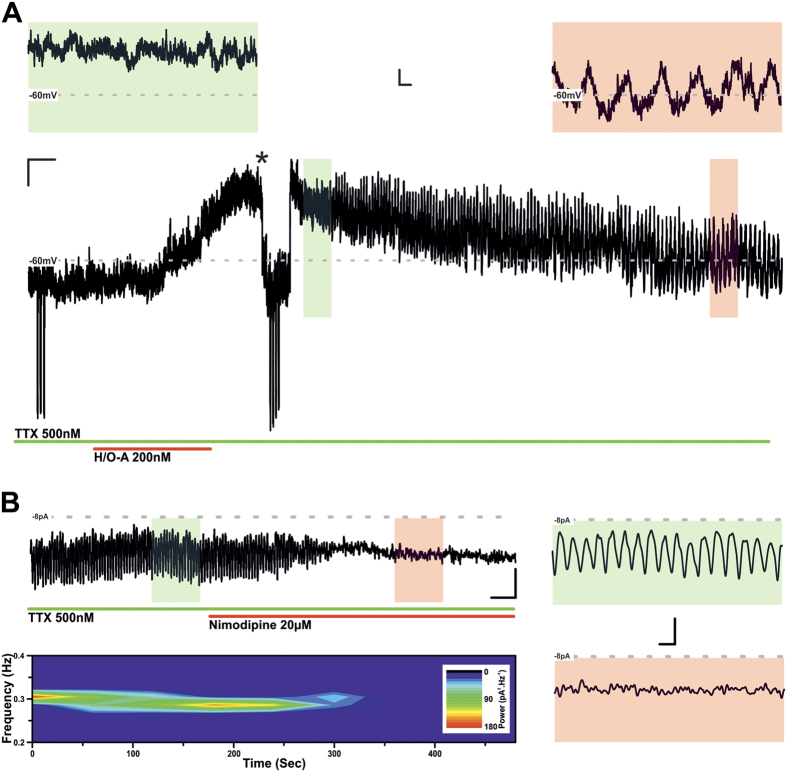
Hypocretin/Orexin-A activates a TTX-insensitive L-type dependent membrane potential oscillation.(A) Current clamp recording of an oscillating TIDA neuron in the continuous presence of TTX. Prior to application of H/O-A, neuron was held at −65 mV with negative DC current injection and input resistance assessed with test pulses of −20pA. Application of H/O-A induced a depolarisation as in (Fig. 2B). However, in 3/9 (33%) of neurons tested, following peak depolarisation (green inset) H/O-A application induced a TTX insensitive membrane potential oscillation with late onset (red inset). Scale bar 5 mV/20 Sec; inset 4 mV/1 Sec. (B) Voltage clamp recording of a TIDA neuron in the continuous presence of TTX and following the application of H/O-A. Trace is filtered at 1 Hz with associated spectrogram shown underneath (Scale bar 4pA/30 Sec). The H/O-A induced, late onset TTX-insensitive oscillation, was abolished by the application of L-type Ca2+ channel blocker nimodipine (3/3, 100%). Shaded areas inset correspond to control (green) and nimodipine (red). Scale bar 4pA/30 Sec; 4pA/4 Sec.